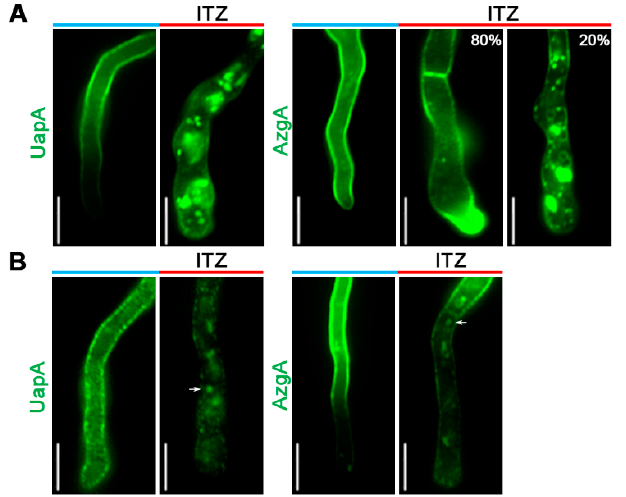
Figure 3. Itraconazole impact on de novo made and PM-localized UapA and AzgA. ( A ) Epifluores- cence microscopy of strains expressing de novo made UapA-GFP or AzgA-GFP from the alcA promoter in the presence or absence of ITZ. Conidiospores germinated overnight (14 h) in 1% glucose MM to repress UapA and AzgA synthesis, and next day ITZ was added for 5 h, before shifting the culture to 0.1% fructose MM to allow derepression of UapA and AzgA for 2 h. Notice the prominent labeling of cytosolic membranous structures and foci, with concomitant reduction of PM labeling by UapA (100%), but also in a significant fraction of AzgA (20%), upon ITZ addition. Biological/technical replicates: 2/20 for each condition. ( B ) Epifluorescence microscopy showing the effect of ITZ on UapA-GFP or AzgA-GFP pre-localized in the PM. Conidiospores were initially germinated overnight (14 h) in 0.1% fructose MM to allow derepression of UapA and AzgA, and next day 1% glucose was added to the culture for 2 h to repress further synthesis of the transporters, before addition of ITZ and further incubation for 5 h. Arrows indicate highly motile foci, compatible with early endosomes and active endocytosis of the transporters. Biological/technical replicates: 2/15. Unless stated otherwise, the images shown represent the outcome observed in 100% of cells examined. Scale bars: 5 µ